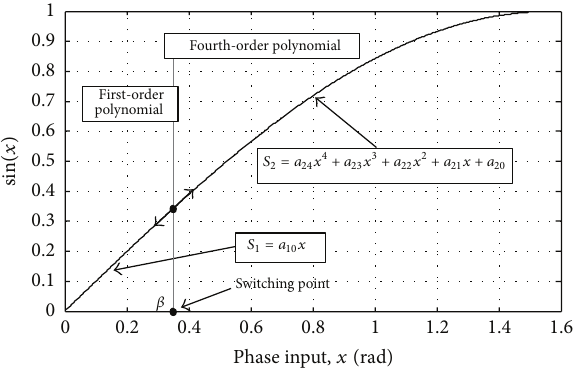
Figure 2: The principle of hybrid polynomial